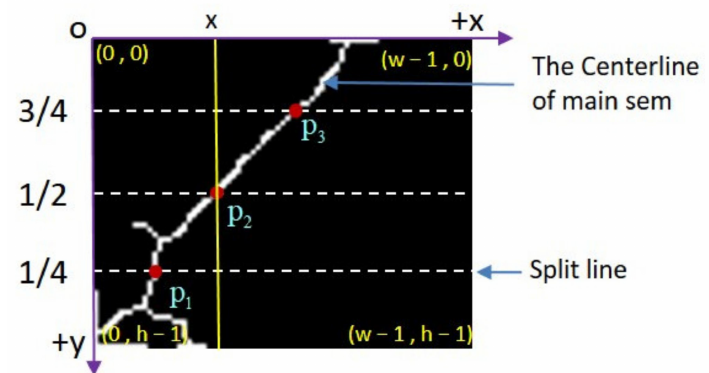
Figure 8. Schematic diagram of acquisition method of pixel coordinates of picking points in main stem ROI image. p 1 , p 2 and p 3 are the selection objects of the picking